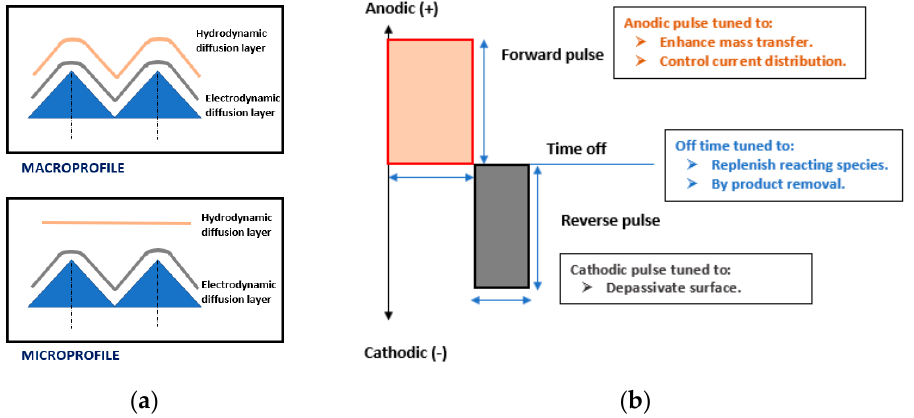
Figure 16. ( a ). Hydrodynamic layer of micro- and macro-profile, ( b ) Generalized pulse/pulse reverse waveform for electropolishing (after Taylor 2001) [53].